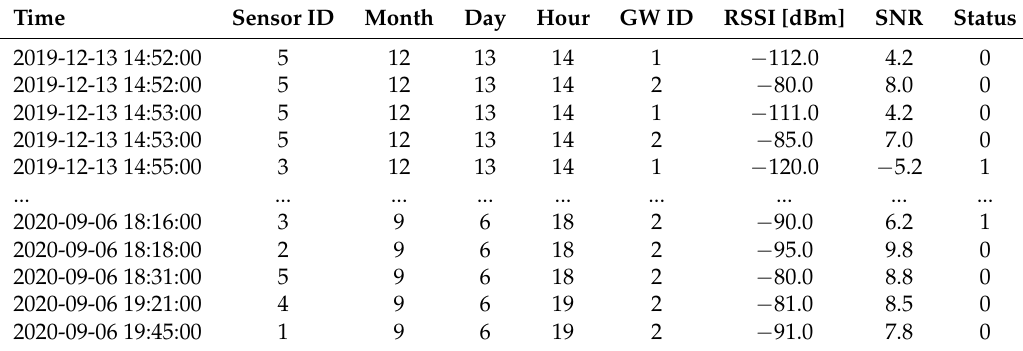
Table 9. Snapshot of a dataframe used for the model of Neural Network.